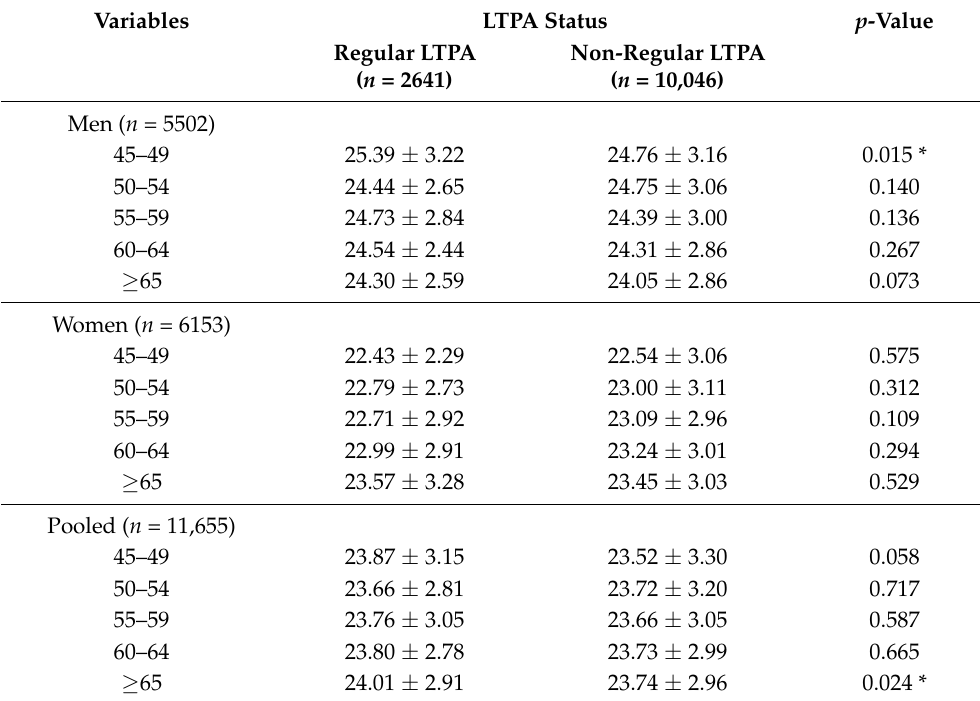
Table 2. Comparison of BMI values according to LTPA status among middle-aged and older adults in